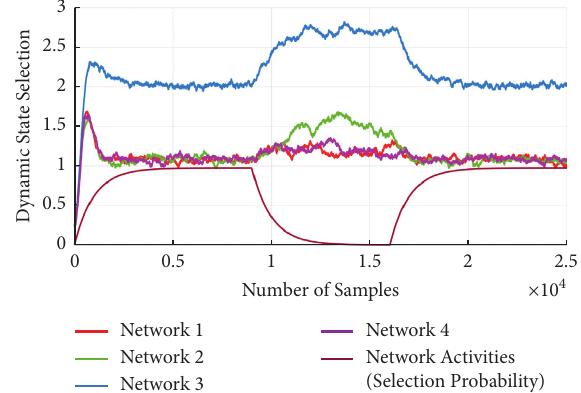
Figure 5: Effect of threshold on network connectivity for � 4 ) . sensitivity � 5 ( V thrl